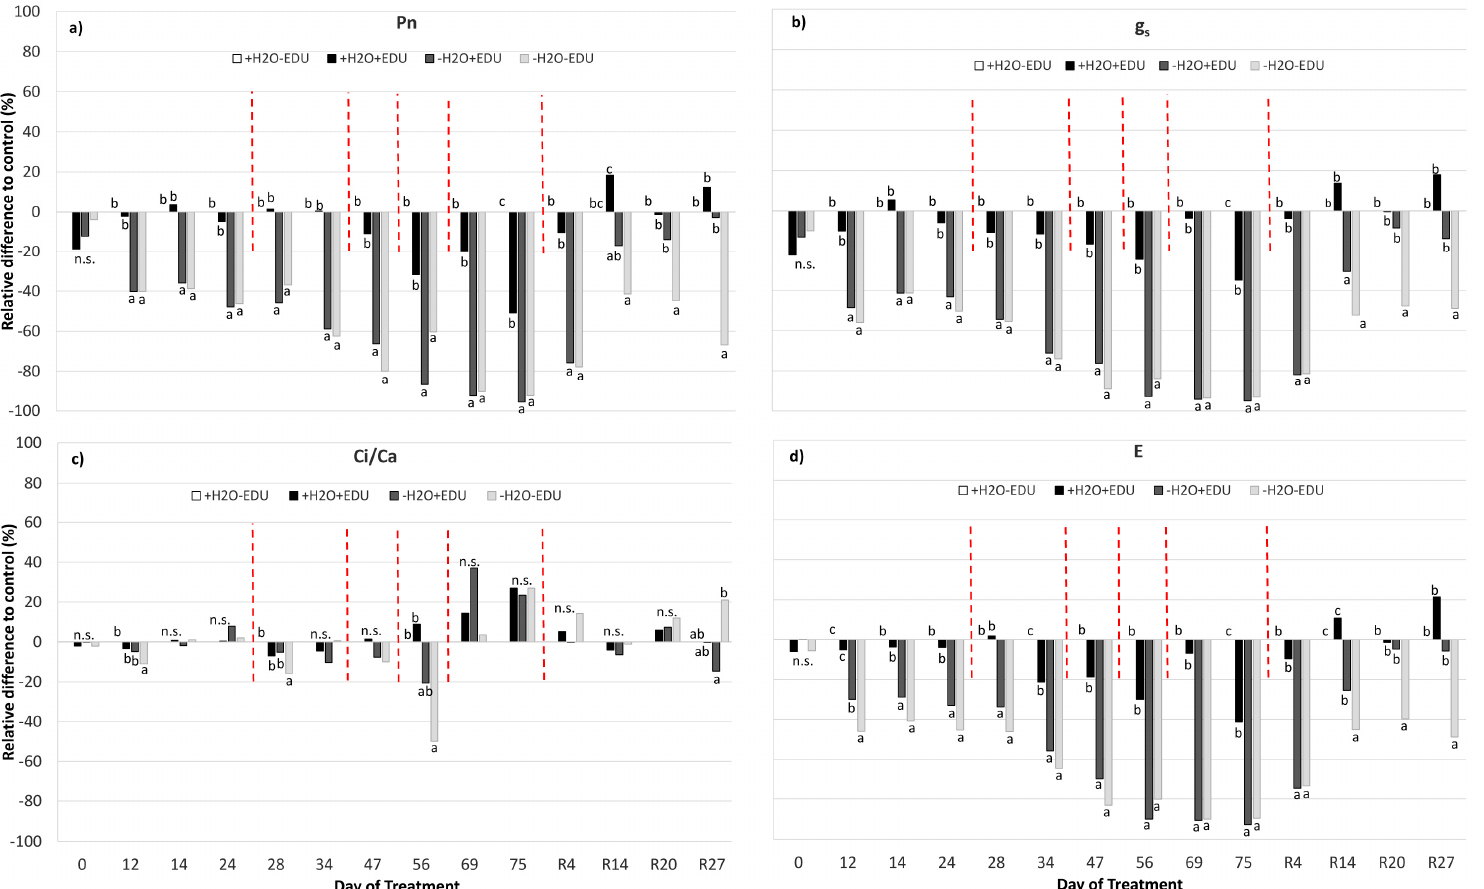
Figure 3. ( a ) Net photosynthesis (Pn); ( b ) stomatal conductance (gs); ( c ) Ci/Ca ratio; and ( d ) leaf transpiration (E) measured during the experimental period. Vertical red dashed bars indicate the dates on which the EDU treatments were applied. On the horizontal axis, the Day of Treatment is reported (0–75 = days from the last irrigation and R4, R14, R20, R27, days from re-watering of the water-stressed mesocosms). For each measurement date, data are expressed as the relative difference with respect to the control set (+H 2 O − EDU), and different letters indicate statistically significant differences between means (9 < N < 30, see Supplementary Table S1).